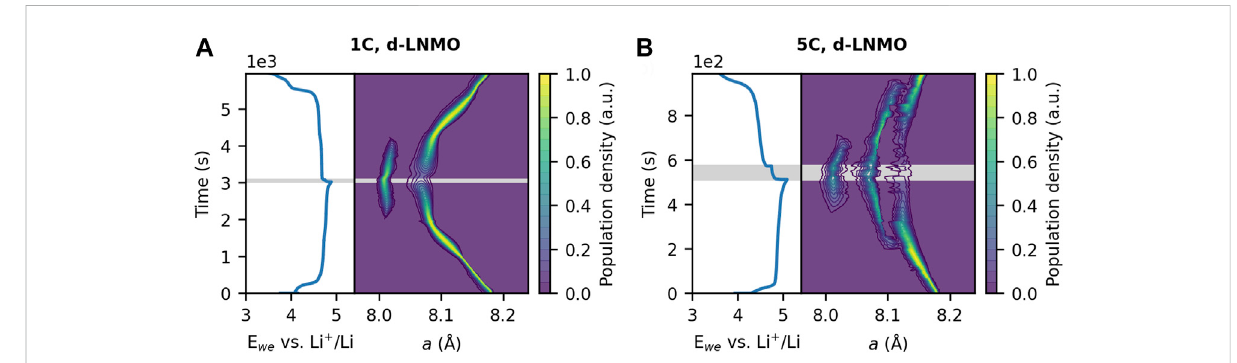
FIGURE 4 Distributionofthelatticeparameter a duringgalvanostaticcyclingat (A) 1Cand (B) 5CofdisorderedLNMO(d-LNMO),togetherwithassociated voltage pro fi les respectively. The lowest contour of the population density is drawn at a value of 0.05. The rest period at OCV is indicated by the shaded grey